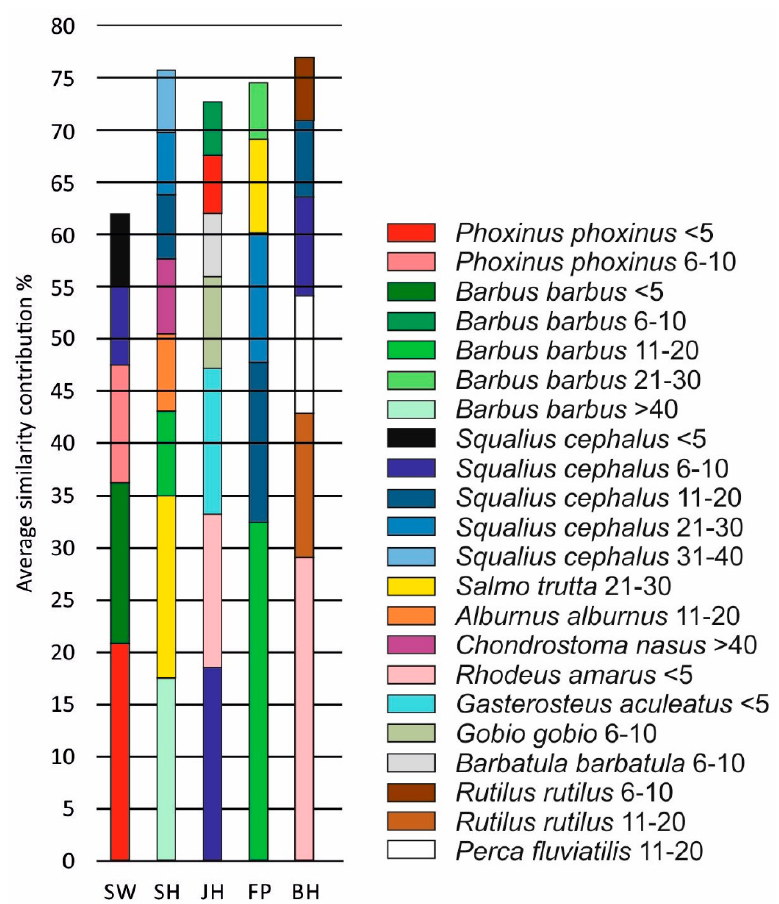
Figure 5. Fish species contribution to ingroup-similarity in the five habitats detected by the SIMPER analysis. JH = structured shallow water zones, BH = bank habitats, SW = former river course below the spillway, SH = fast flowing instream habitat with gravel, and FP = nature like fish pass. Only species with a contribution to the overall ingroup-similarity of more than 5% are shown.